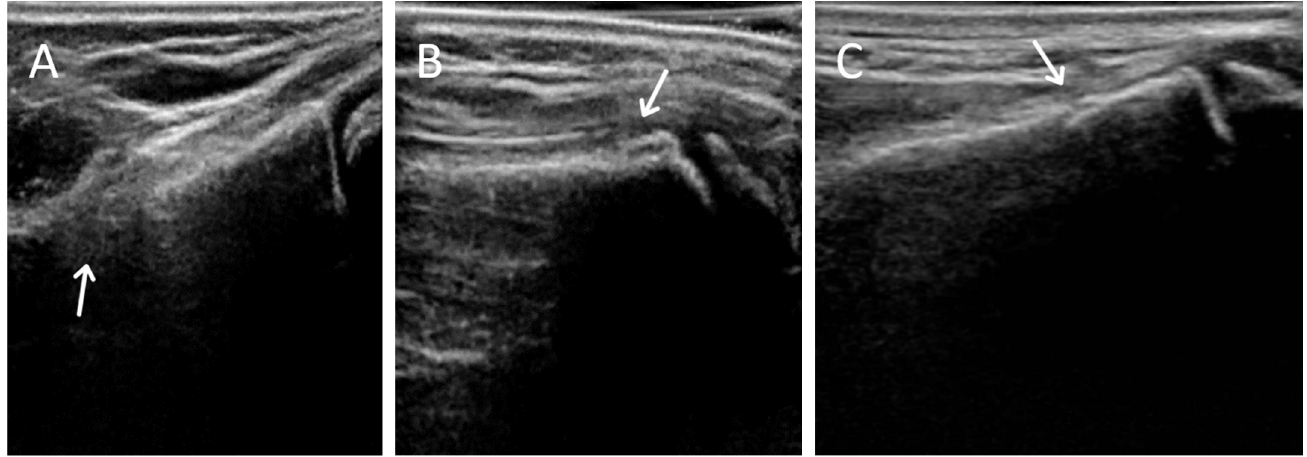
Figure 3 . Examples of 3DUS scanning artifacts. ( A ) Edge effects, ( B ) double cortex from motion, ( C ) overlapping cortex.